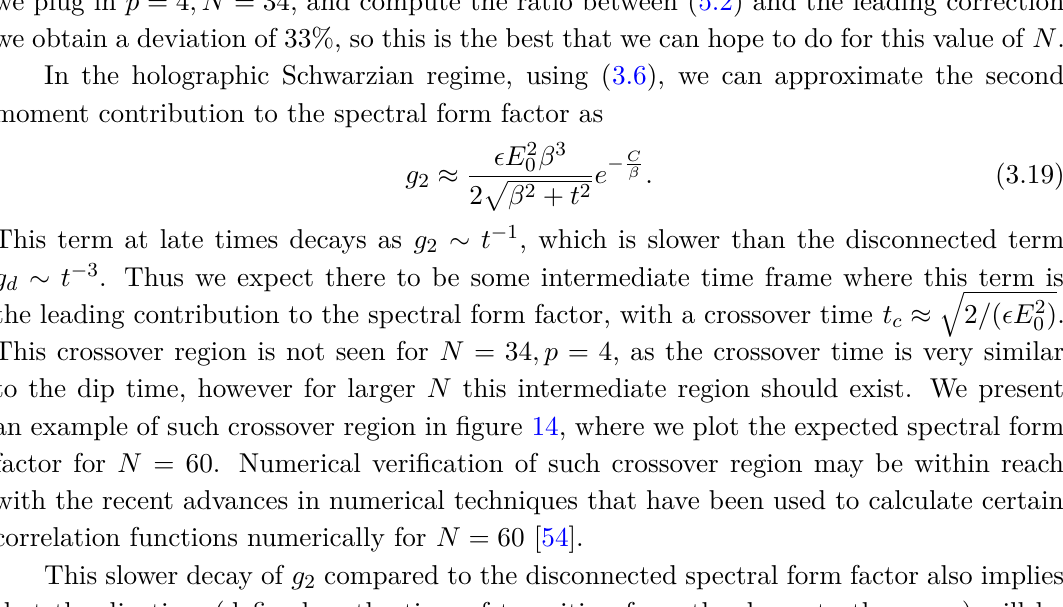
Figure 13 . The approximate spectral form factor as a function of time for N = 34 and p = 4 . g = g d + g 2 + g RMT is the full spectral form factor, g d is the disconnected portion given by the first term in (3.18), g is the leading connected portion given by the second term in (3.18), and g 2 the universal random matrix contribution given by the last term in (3.18). The connected spectral form factor g = g − g is also shown. These are matched to the numerical computation of g and c d g c from